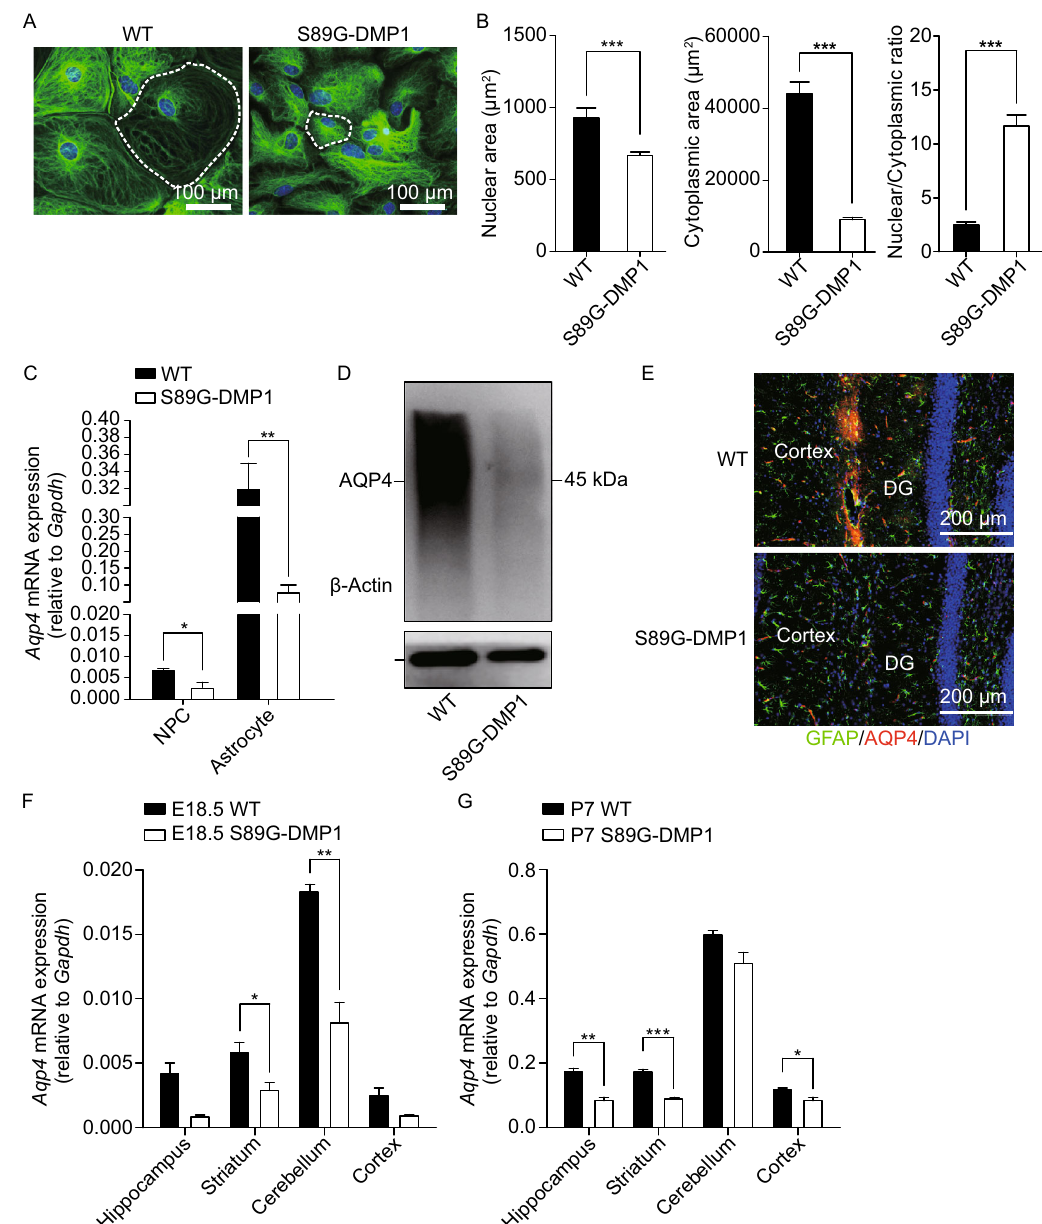
Figure 3. Reduction of astrocyte volume and AQP4 expression in S89G-DMP1 astrocytes. (A) Primary astrocytes cultures derived from S89G-DMP1 showed shrinkage in morphology; (B) The ratio of nucleus to cytoplasm decreased in S89G-DMP1 astrocytes; n = 32 cells for WT; n = 104 cells for S89G-DMP1. (C) AQP4 mRNA expression and (D) protein expression were decreased in astrocytes differentiated from NSCs; (E) Immuno fl uorescence staining showed decreased AQP4 protein expression in S89G-DMP1 cortex; (F) AQP4 mRNA in different brain regions of WT and S89G-DMP1 mice at embryonic Day 18.5, and (G) at postnatal Day 7; n = 3 – 4 mice per genotype. (H) Heatmap of differentially expressed genes in S89G-DMP1 astrocytes compared to WT controls; up-regulated (I) and down-regulated KEGG pathways (J) in S89G-DMP1